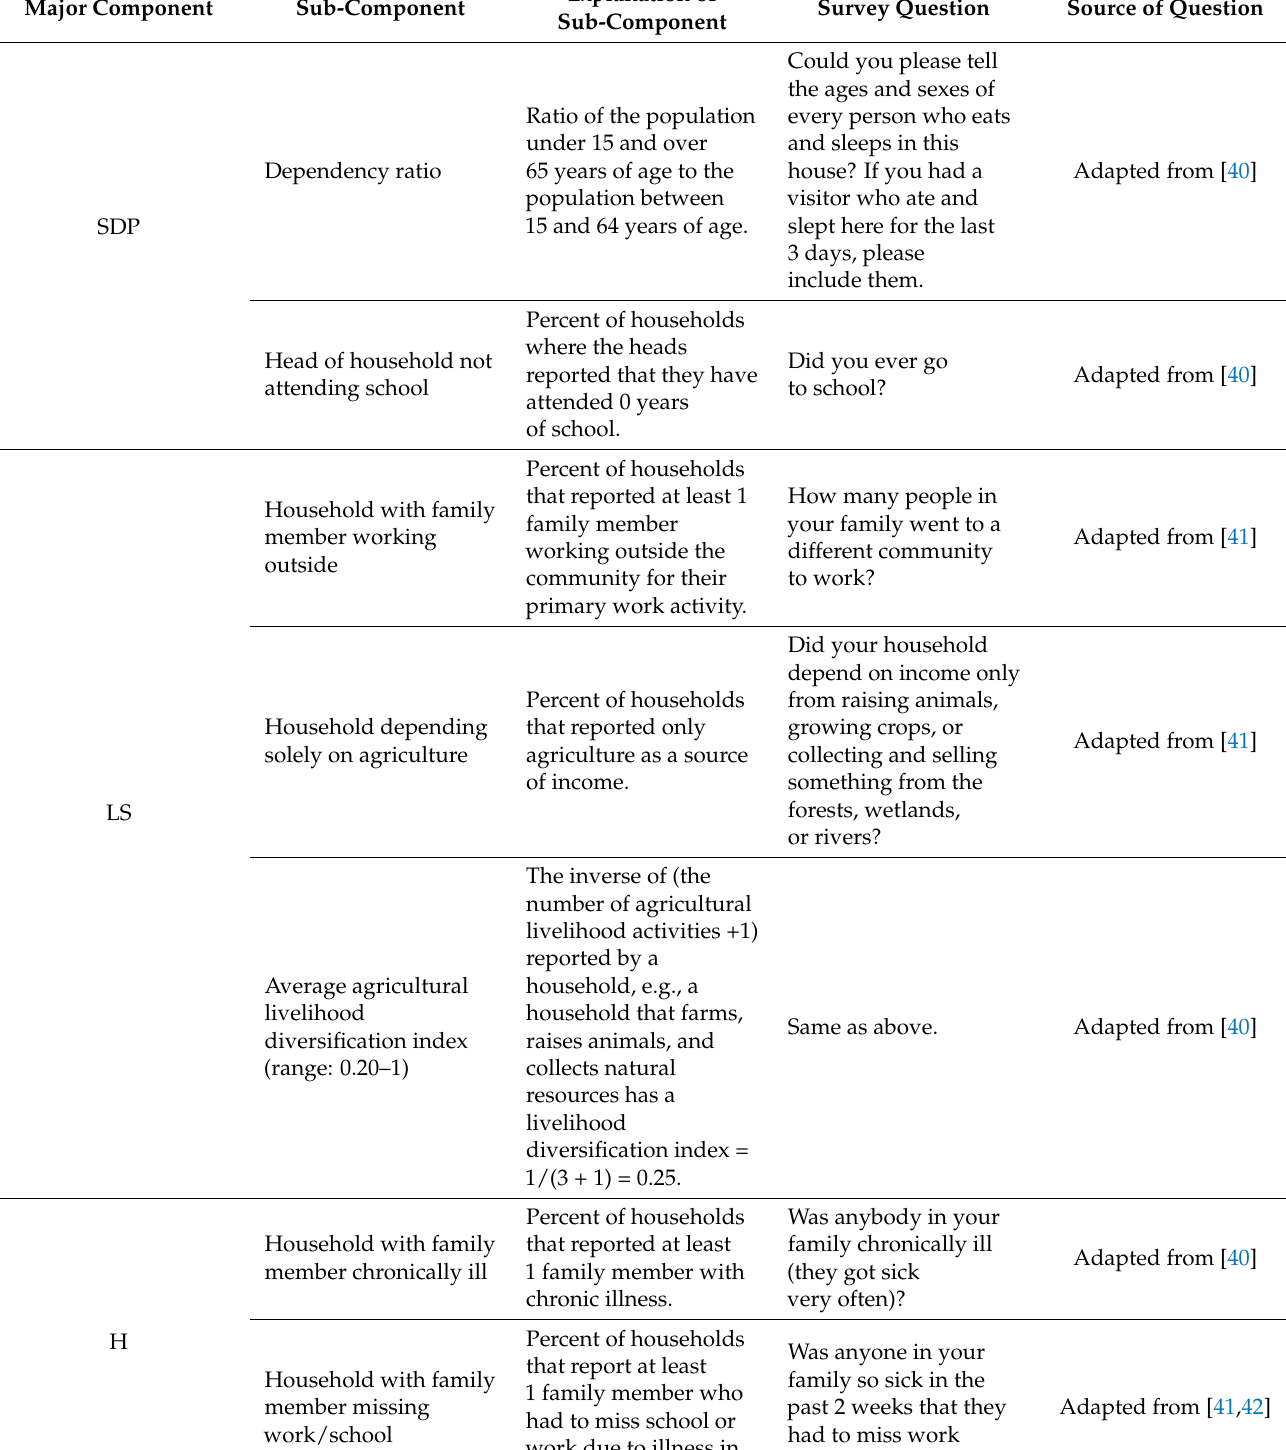
Table 1. Major components and sub-components of